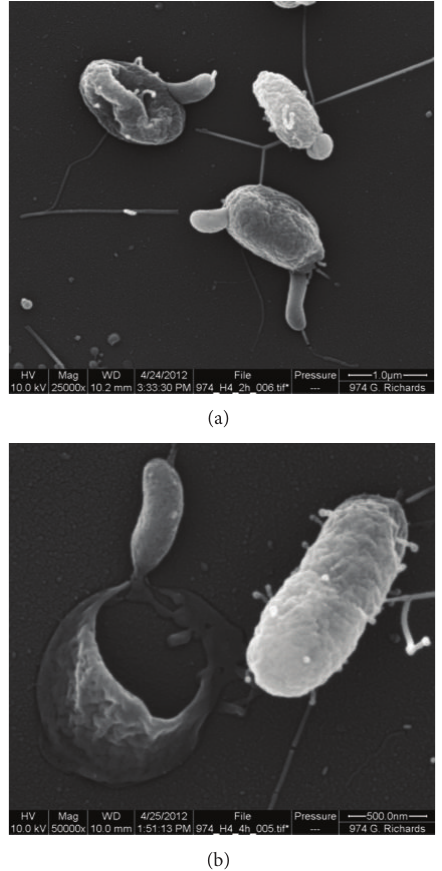
Figure 6: Scanning electron micrographs of Bacteriovorax infecting Vibrioparahaemolyticus .(a)Threevibriosshownwith Bacteriovorax apparently entering (infecting) the Vibrio (lower right). The upper left cell shows a late-stage-infected Vibrio with the immature Bacteriovorax emerging from the cell. Note the appearance of the remaining wormlike Bacteriovorax within the partially shrunken Vibrio . (b) Immature stage Bacteriovorax (upper left) emerging from a dead Vibrio . Note the single hole in the Vibrio from which multiple immature Bacteriovorax would have emerged. An apparently uninfected Vibrio is shown on the